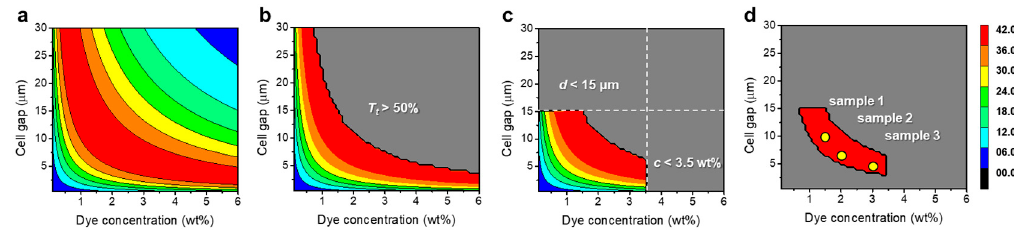
Figure 7. An example of the proposed design process for a ChLC cell on a constant transmittance- difference contour map. ( a ) The constant transmittance-difference contour map of a ChLC cell. ( b ) The region that does not satisfy the minimum transmittance in the transparent state is excluded. ( c ) The regions that do not satisfy the conditions of the cell gap and dye concentration are excluded. ( d ) The regions that do not satisfy the minimum transmittance difference are excluded. The yellow dots represent the fabrication condition for the 3 samples.